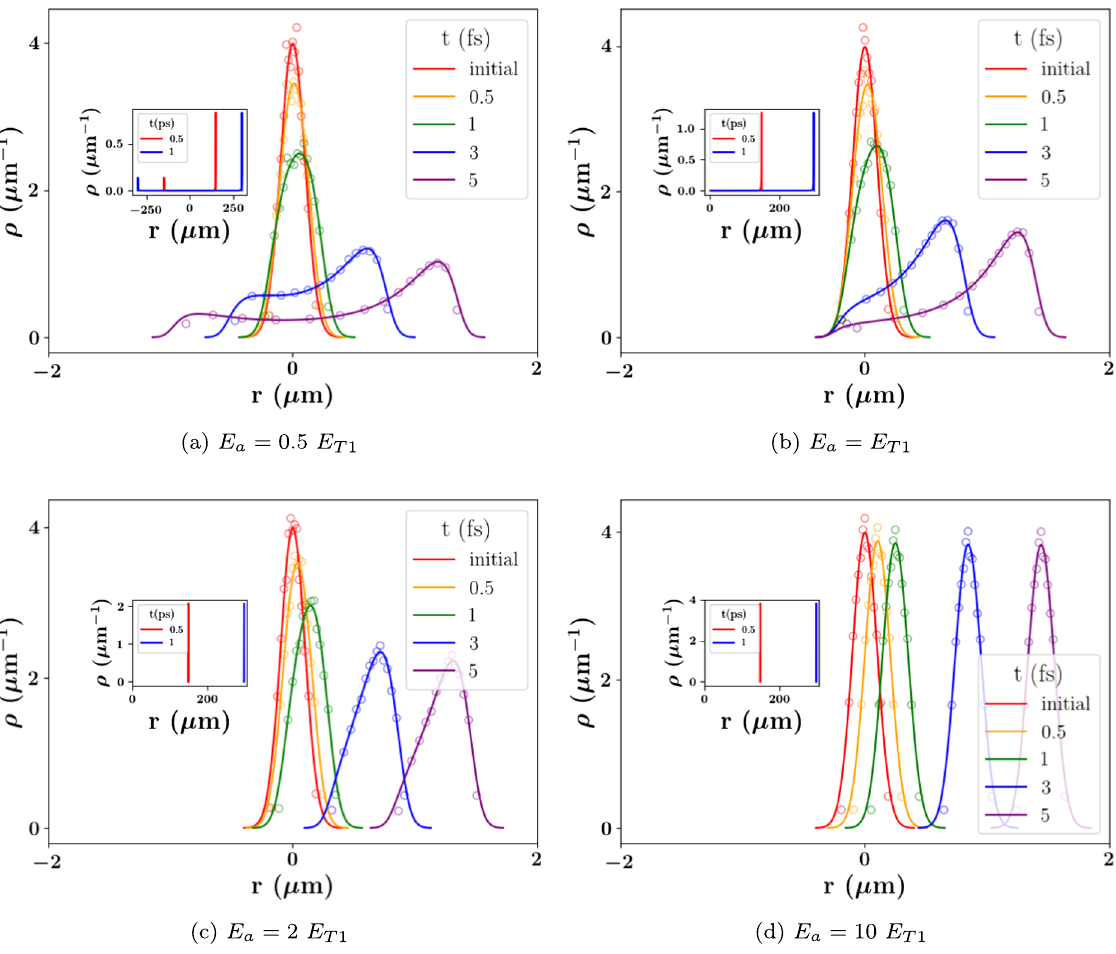
FIG. 12. Theoretical predictions (solid line) and M -shell simulations (hollow dots) of the planar symmetric density at 4 different times with different applied extraction fields: (a) E Q is the total surface-charge density. Parameters and simulations are analogous to those described in Fig. 11 excepting the initial tot ; 1 Gaussian distribution with σ